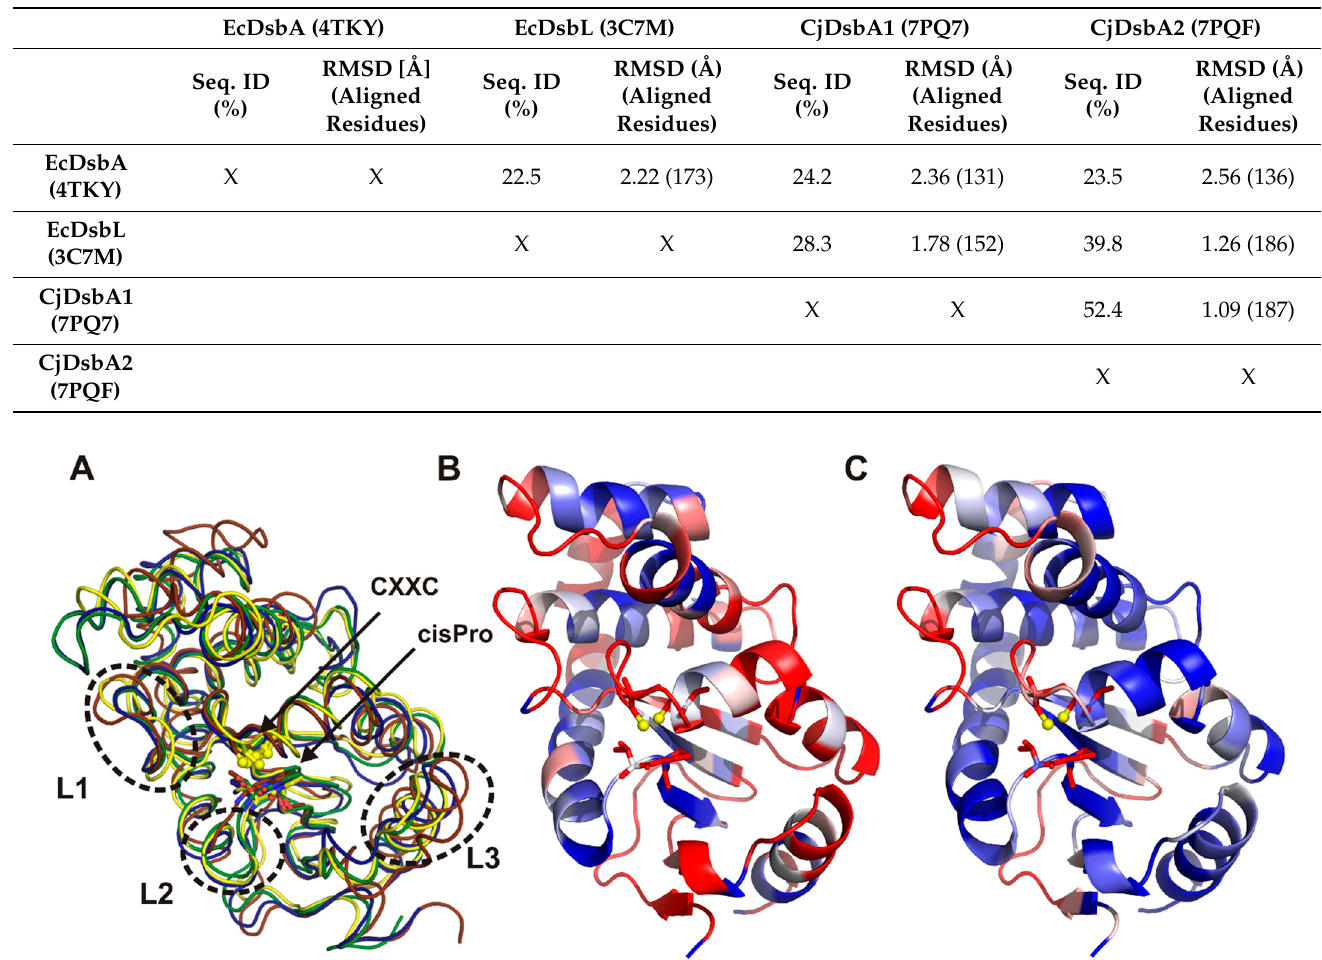
Figure 7. ( A ) Superposition of CjDsbA1 (yellow) and CjDsbA2 (green) compared with previously known structures of EcDsbL (blue) and EcDsbA (red). Structures are presented as tubes colored according to particular model; for consistency and clarity, the coloring was maintained throughout the manuscript. The catalytic CXXC motif and the opposing cis-proline motifs are additionally shown as sticks and colored according to element (oxygen—red; nitrogen—blue; sulfur—yellow; carbon as in the tube) and indicated by labels. Additionally, the L1, L2 and L3 regions mentioned in the text and detailed in Table 3 are indicated by dashed line ellipses and labelled accordingly. ( B , C ) highlight the extent of structural variability by coloring the overall structure of CjDsbA1 presented as a cartoon by per residue differences against EcDsbL (middle, panel ( B )) and CjDsbA2 (right, panel ( C )). Coloring based on main chain RMSD value (1.5 Å red–1.0 Å white–0.5 Å blue) between a given position in the CjDsbA1 and the compared (superposed) protein. The cis-proline motif and active site cysteines are shown as sticks with sulfur atoms presented as yellow spheres. This visually indicates higher similarity of the two C. jejuni proteins than similarity towards EcDsbL protein, what is also numerically expressed in Table